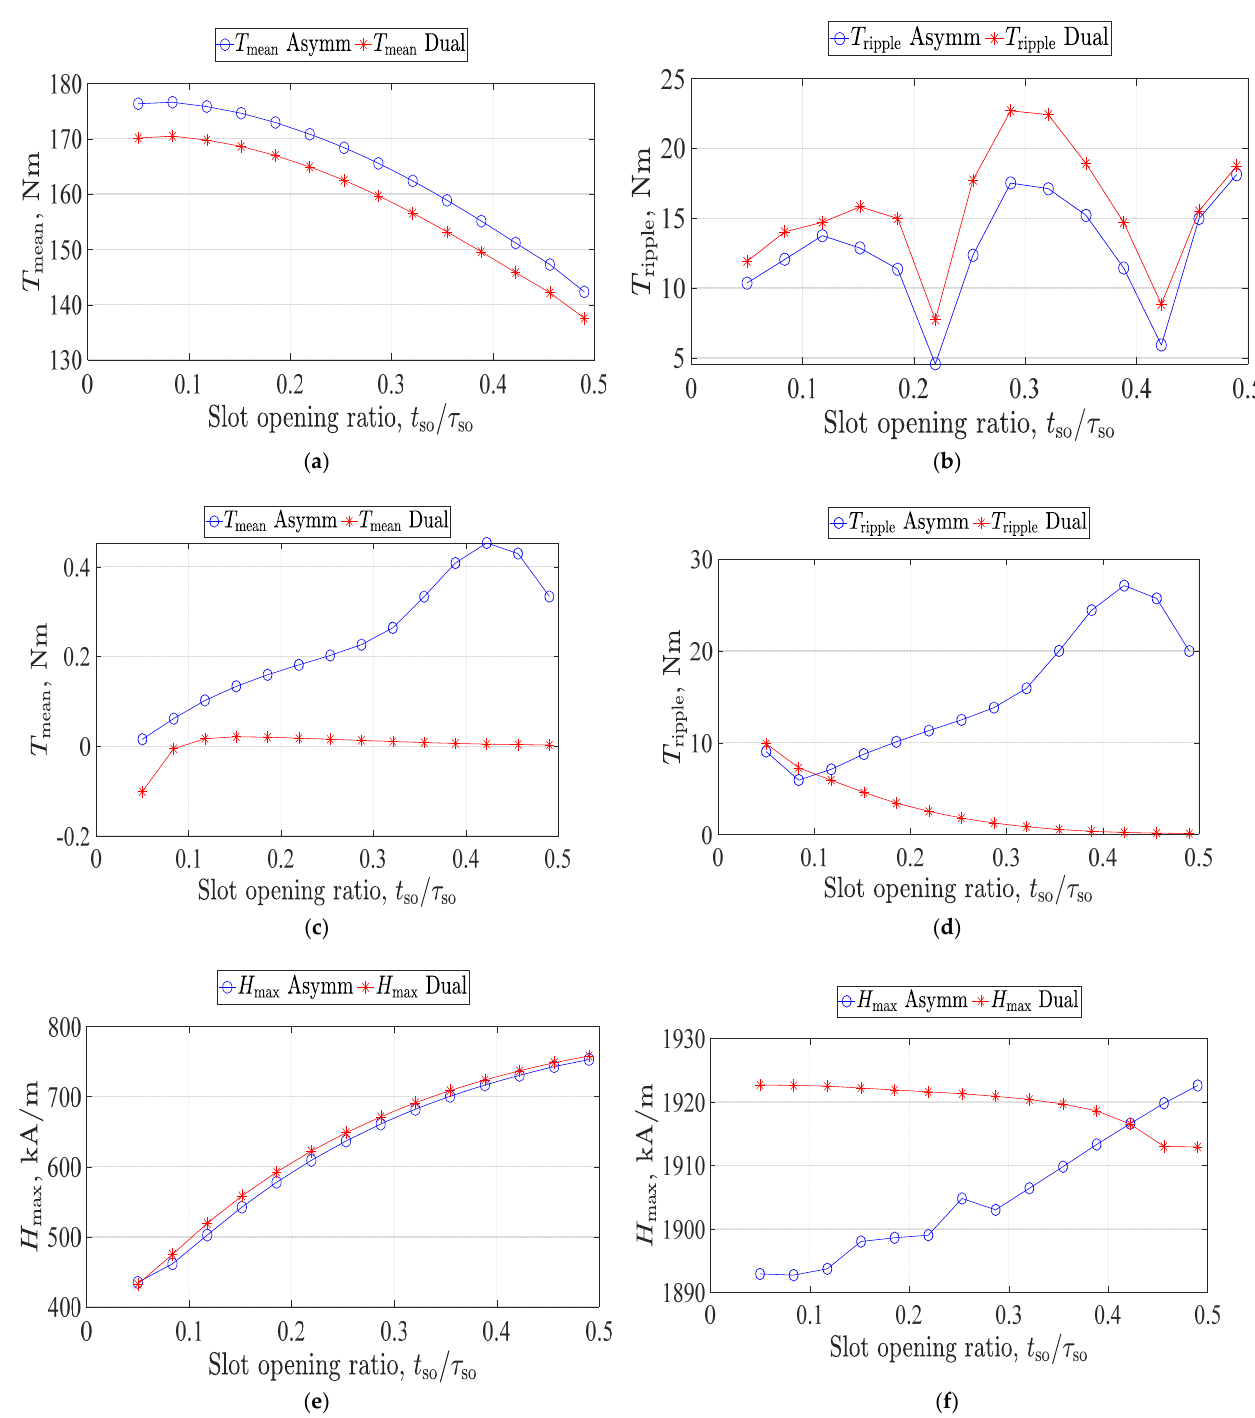
Figure 7. Torque profiles and maximum PM magnetic field intensity with respect to slot opening width. ( a ) Average torque under propulsion. ( b ) Torque ripple under propulsion. ( c ) Average torque under charging. ( d ) Torque ripple under charging. ( e ) Maximum magnetic field intensity in the PMs under propulsion. ( f ) Maximum magnetic field intensity in the PMs under charging.